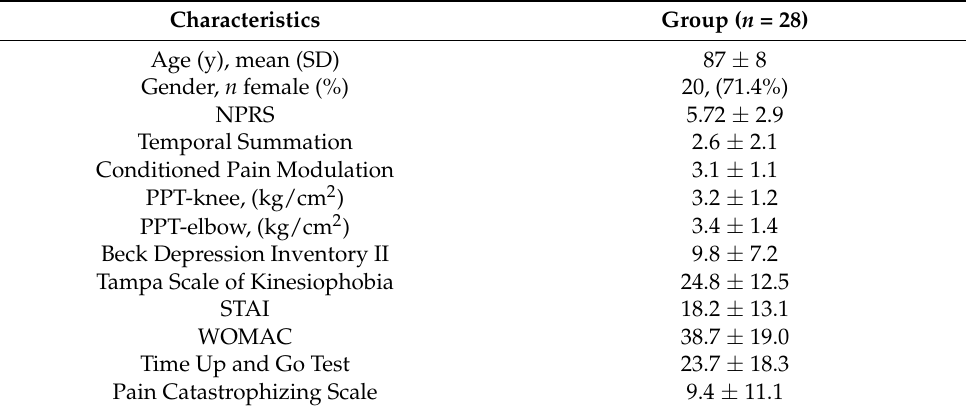
Table 1. Characteristics of the participants at